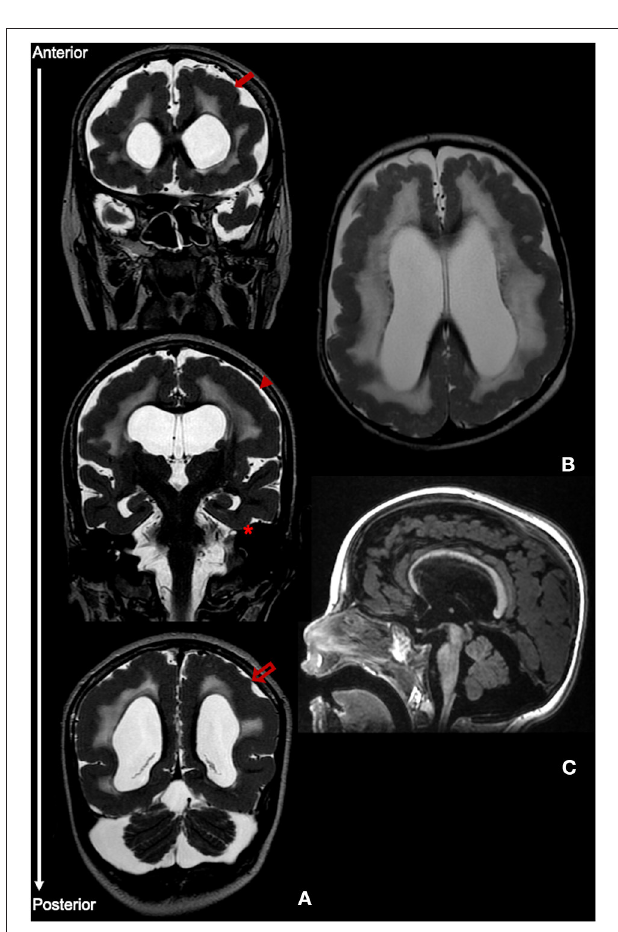
FIGURE 2 | MRI findings at age 11 years. (A) Coronal T2-weighted images showing PMG without an anterior-posterior gradient of involvement, including frontal cortex (closed arrow), parietal cortex (arrowhead) and occipital cortex (open arrow). There is relative sparing of the temporal lobes (asterisk). (B) Axial T2 image displaying diffuse white matter hypomyelination. (C) Sagittal T1 image highlighting pontine and cerebellar